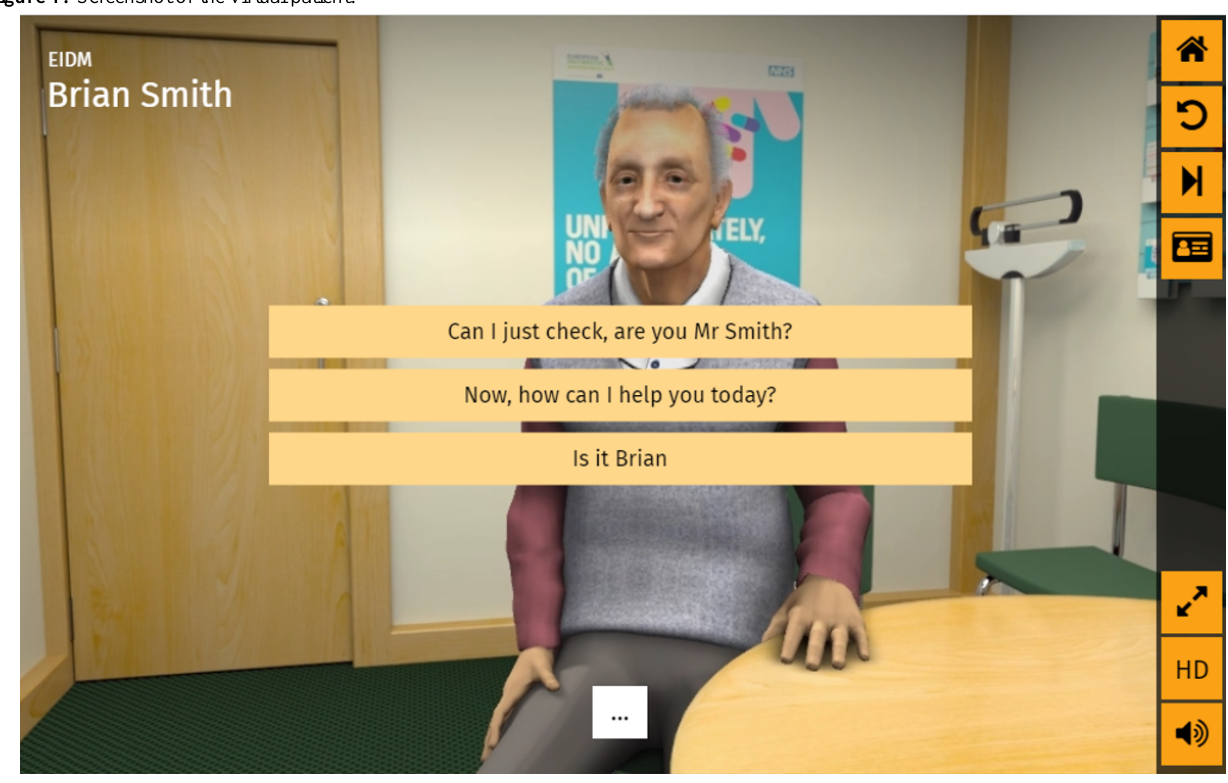
Figure 1. Screenshot of the virtual